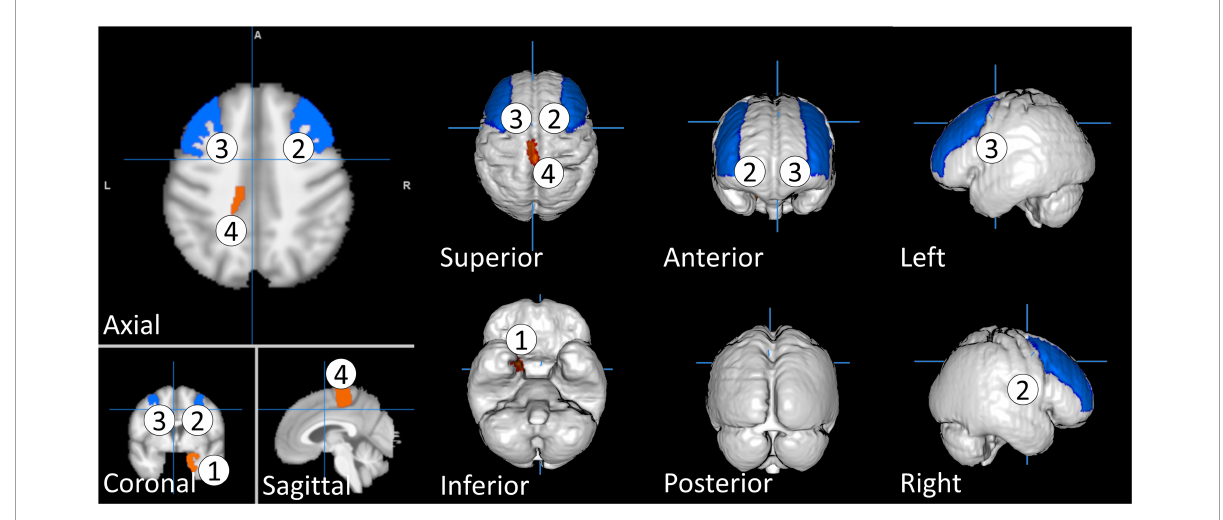
FIGURE3 The regional gray matter volume that is significantly different between desk work and non-desk work participants. The regional gray matter volume is color-coded based on t values, with red indicating negative t value and blue indicating positive t value. We coded deskwork group as sample 1 and non-deskwork group as sample 2. The rGMVs are as follows: 1. Right entorhinal area, 2. Right middle frontal gyrus, 3. Left middle frontal gyrus, and 4. Left precentral gyrus medial